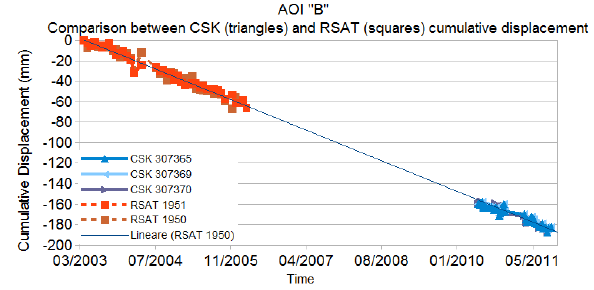
Figure 10: Displacement recorded in the AOI "B" using Cosmo-SkyMed and Radarsat